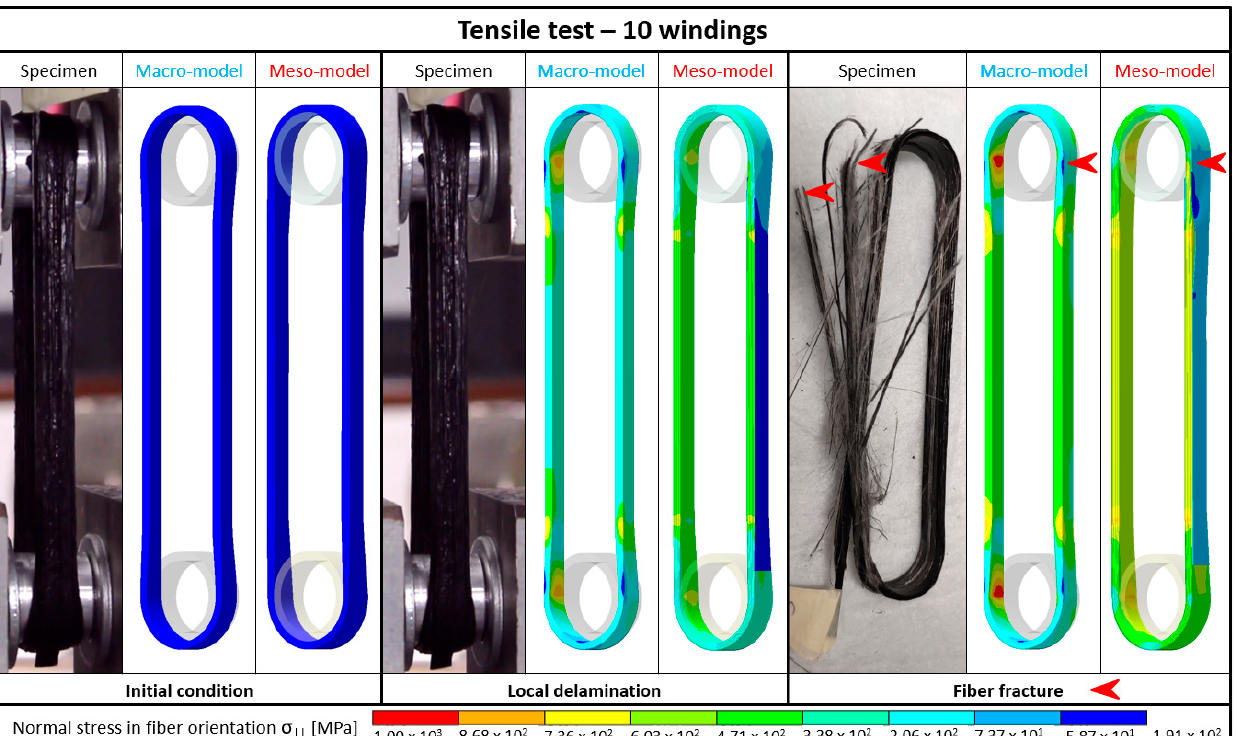
Figure 21. Load-displacement curves from tensile tests on simple loops with ten windings (meas- ured and calculated).